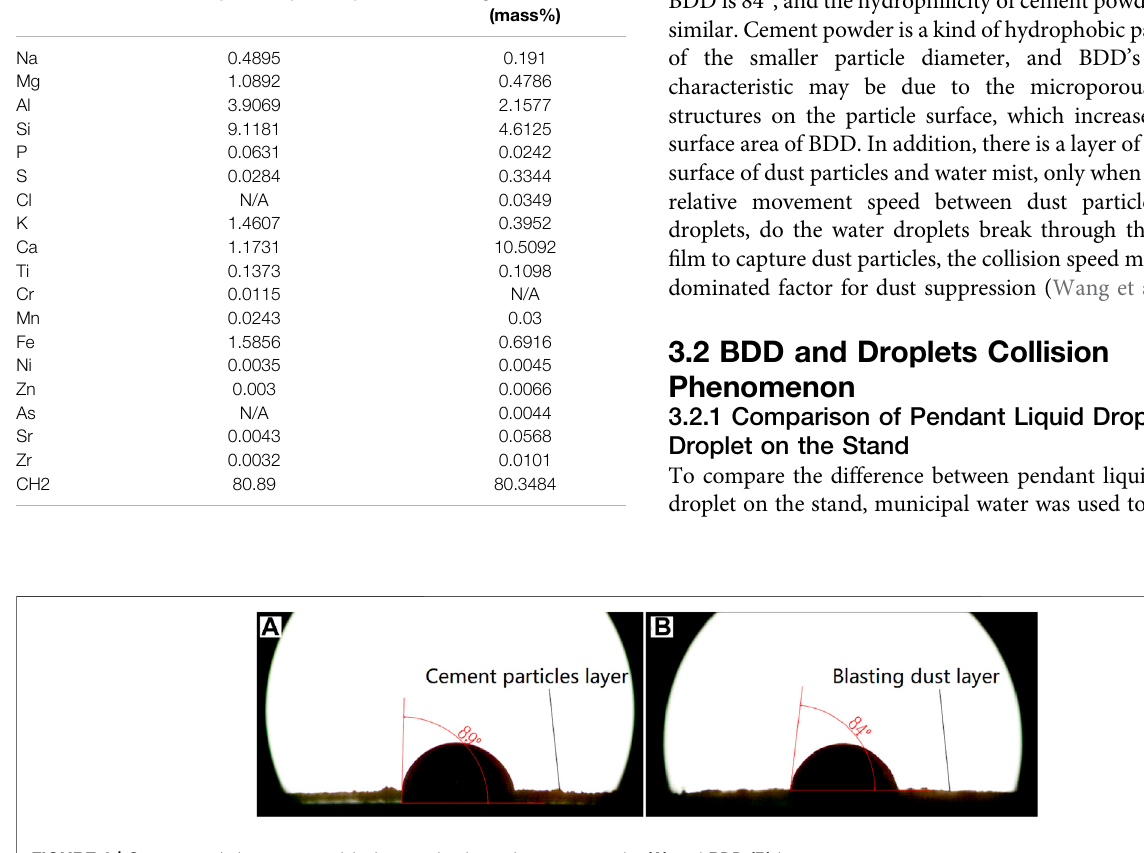
FIGURE 6 | Contact angle between municipal water droplet and cement powder (A) and BDD (B) layer.